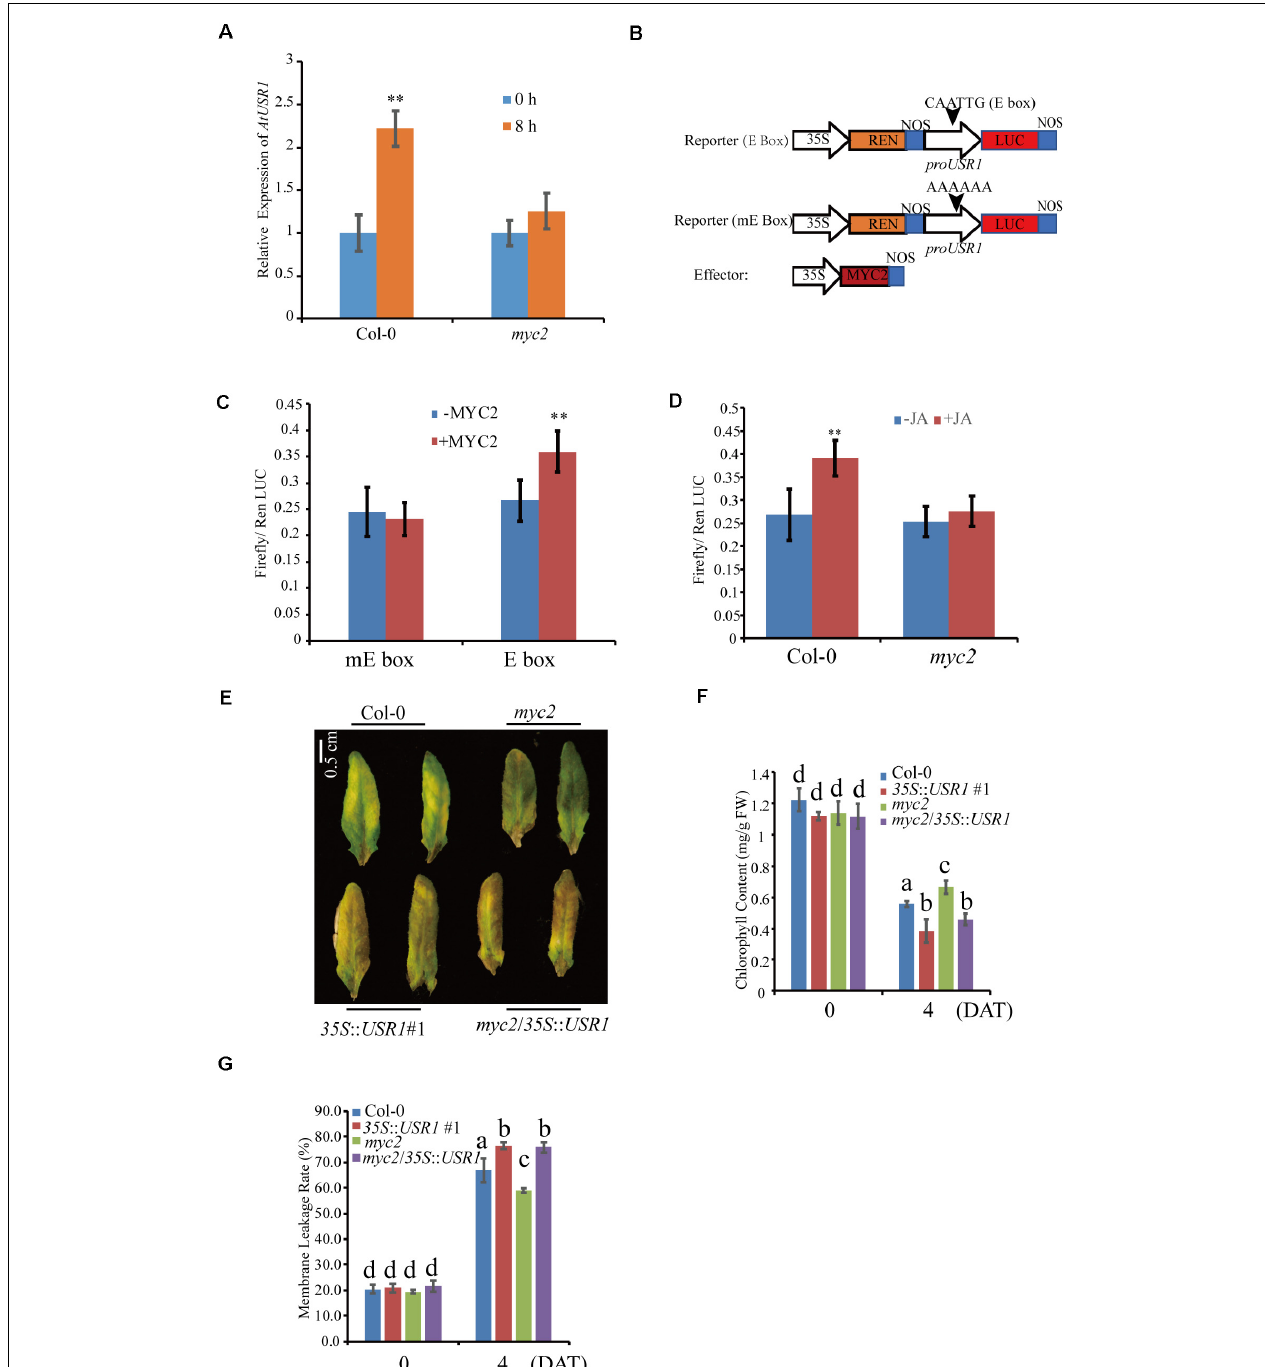
FIGURE 7 | AtUSR1 functions downstream to MYC2. (A) The expression pattern of AtUSR1 in Col-0 and the myc2 mutant under 100 µ M MeJA treatments. (B) Schematic diagram of the reporter and effector constructs used in the dual luciferase assay. (C) MYC2 increased the activities of the AtUSR1 promoter. The promoter of AtUSR1 containing an E-box (CAGCGT) or a mutant version of the E-box (AAAAAA) fused with LUC was co-transformed with an effecter construct with or without 35S :: MYC2 into Col-0 protoplasts. Ren LUC activity acted as internal control. The experiments presented here were done only with Col-0 plants (labeled as –MYC2). (D) MeJA induced the expression of AtUSR1 and this induction was MYC2-dependent. The reporter construct ( proAtUSR1 :: LUC ) was transformed into protoplasts of Col-0 or myc2 , respectively. Ren Luc acted as an internal control. (E) The cross line myc2/35S::USR1 rescued the delayed senescence phenotype of myc2 under MeJA treatments. (F) Chlorophyll contents in different genotypes as indicated. (G) Membrane leakage rates in different genotypes as indicated. **Indicate significant difference at P < 0.01 levels using student’s t -test. Data are shown as the mean ± SD from three independent experiments. The data in (F,G) different letters above columns indicate significant differences according to Duncan’s multiple range test ( P < 0.05).